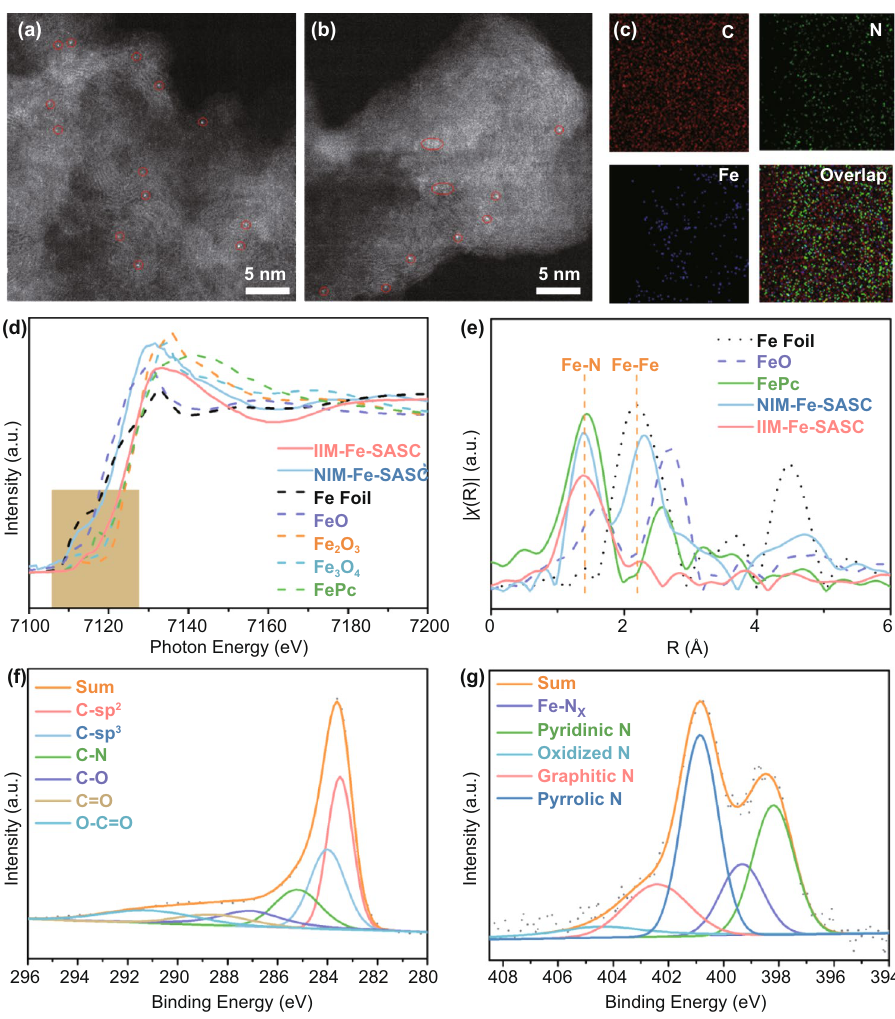
Fig. 2 a , b HAADF-STEM images of IIM-Fe-SASC and NIM-Fe-SASC, respectively. c Elemental -mapping images of IIM-Fe-SASC. d Fe K-edge XANES spectra of IIM-Fe-SASC, and reference samples of FePc, Fe foil, FeO, Fe 2 O 3, and Fe 3 O 4 . e FT k 2 -weighted EXAFS R-space spectra of IIM-Fe-SASC, NIM-Fe-SASC, FePc, Fe foil, and Fe 2 O 3 . f , g C 1 s and N 1 s XPS spectra of